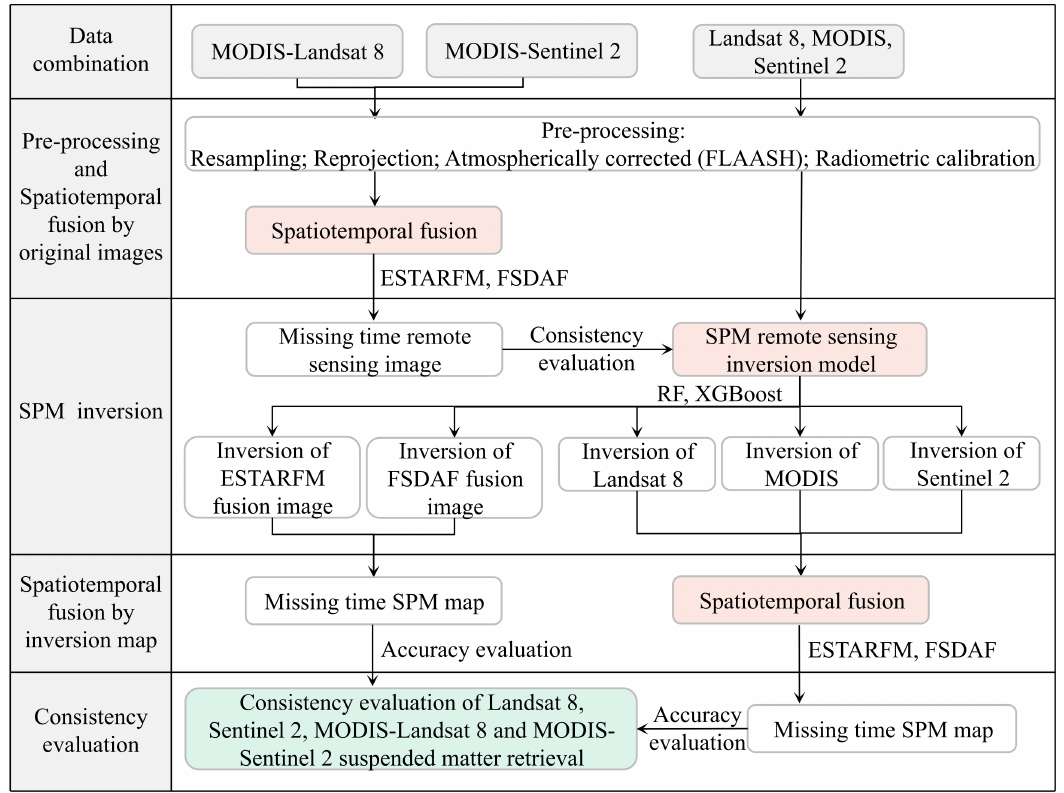
Figure 5. The workflow of this